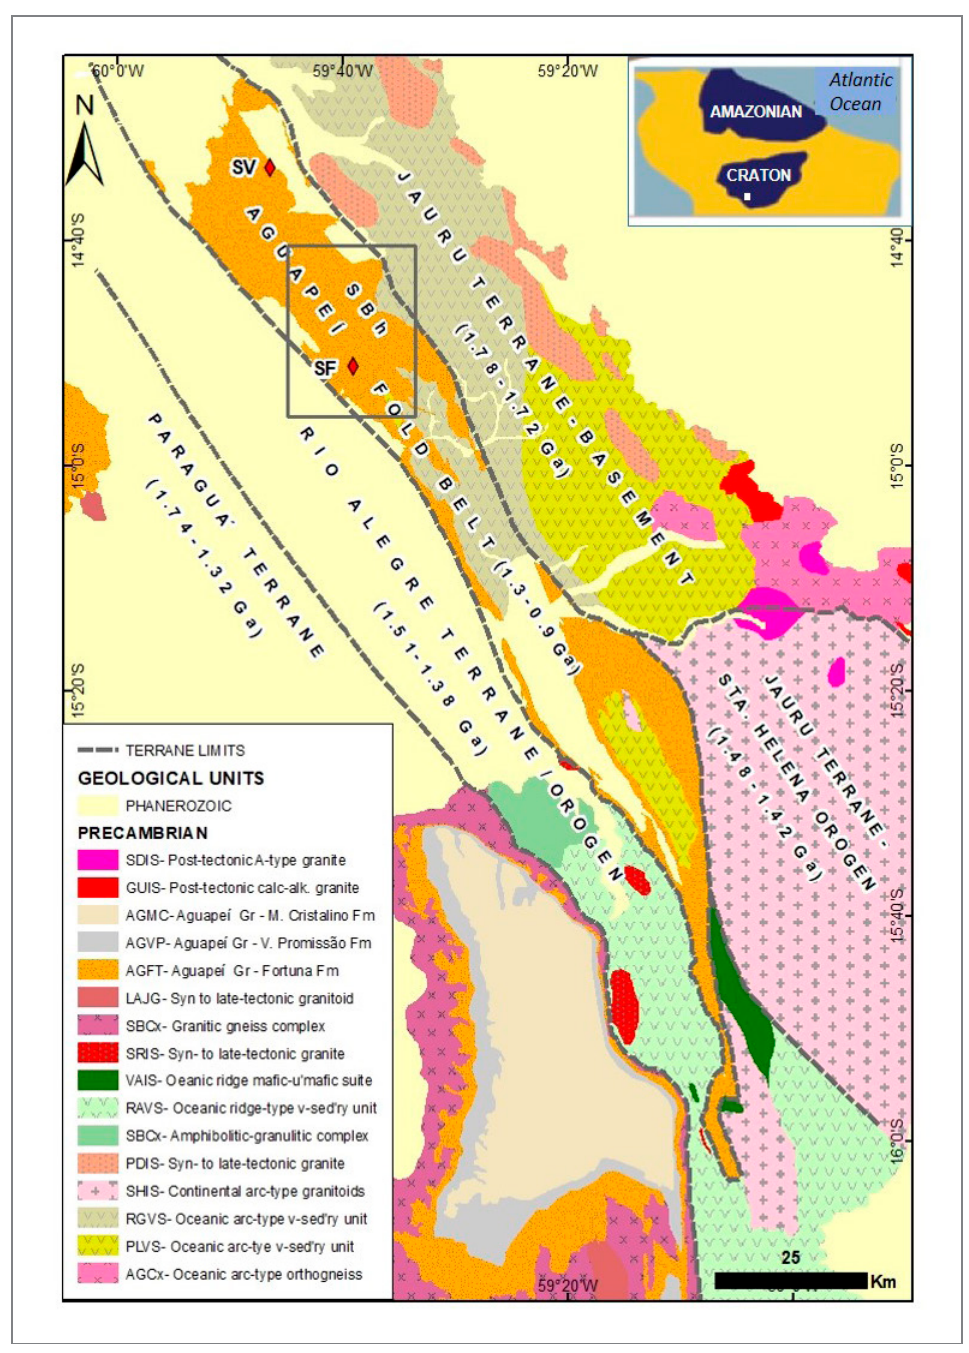
FIGURE 1 - Geology map of the Aguapeí fold belt region showing main tectonic elements and geologic units of the Serra da Borda hills (SBh), the siliceous breccia and metachert occurrence area (black outline), and the location of the São Francisco (SF) and São Vicente (SV) gold mines (modified after Lacerda Filho et al. 2004; Ruiz 2005; Bettencourt et al. 2010; Teixeira et al. 2010). JAURU TERRANE: AGCx- Alto Guaporé gneissic complex, PLVS- Pontes e Lacerda volcanic-sedimentary unit, RGVS- Rio Galera volcanic-sedimentary unit, SHIS- Santa Helena intrusive suite, PDIS- Pindaituba intrusive suite. RIO ALEGRE TERRANE: SBCx- Santa Bárbara granulitic complex, RAVS- Rio Alegre volcanic-sedimentary unit, VAUS- Vale do Alegre ultramafic suite, SRIS- Santa Rita intrusive suite. PARAGUÁ TERRANE: SBCx- Serra do Baú gneissic complex, LAJG- Lajes granitoid. AGUAPEÍ BELT: HGFT- Fortuna Fm, AGVP- Vale da Promissão Fm, AGMC- Morro do Cristalino Fm. LATE GRANITES: GUIS & SDIS- Guapé & São Domingos intrusive